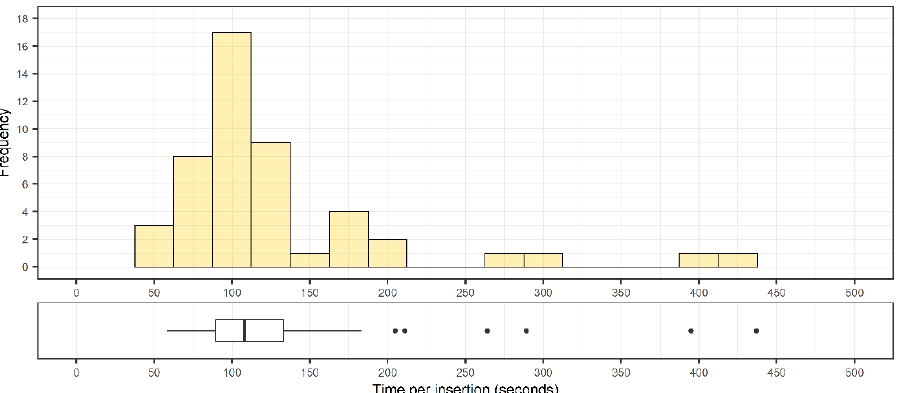
Figure 7. Distribution of screw implantation times (n = 48) with corresponding box plots indicating median, interquartile range, and outliers from the distribution.